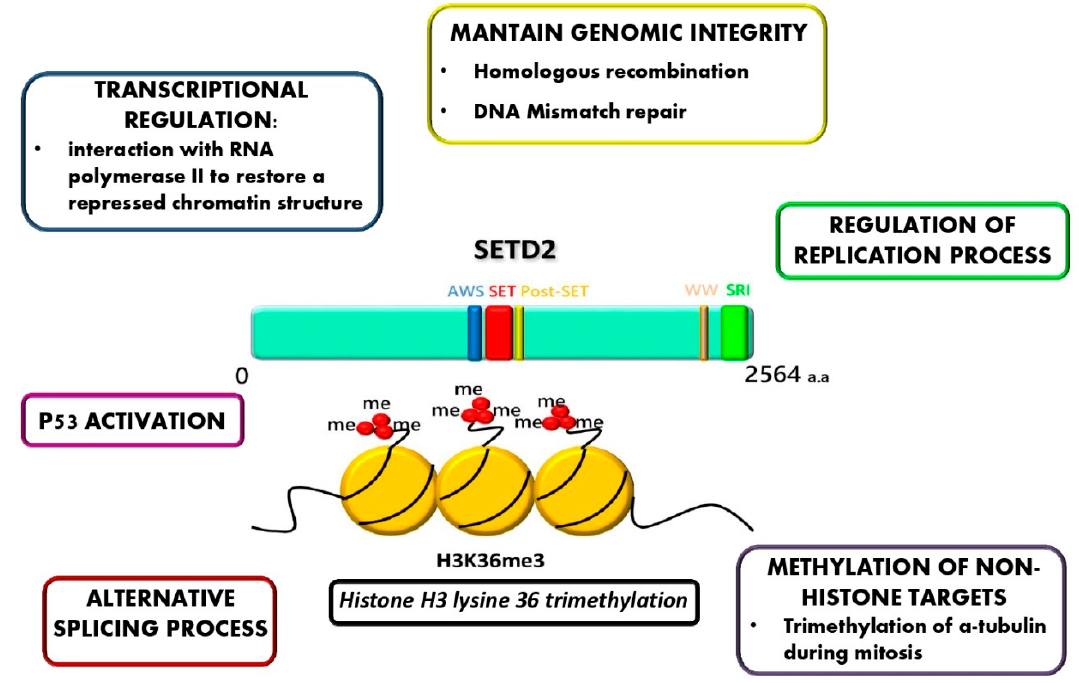
Figure 2. Schematic overview of the localization of the key functional domains of the SETD2 protein and its known roles. SETD2-mediated H3K36 tri-methylation is implicated in several cellular processes including: transcriptional regulation, genomic integrity, regulation of replication, methylation of non-histone targets, alternative splicing, and p53 activation.